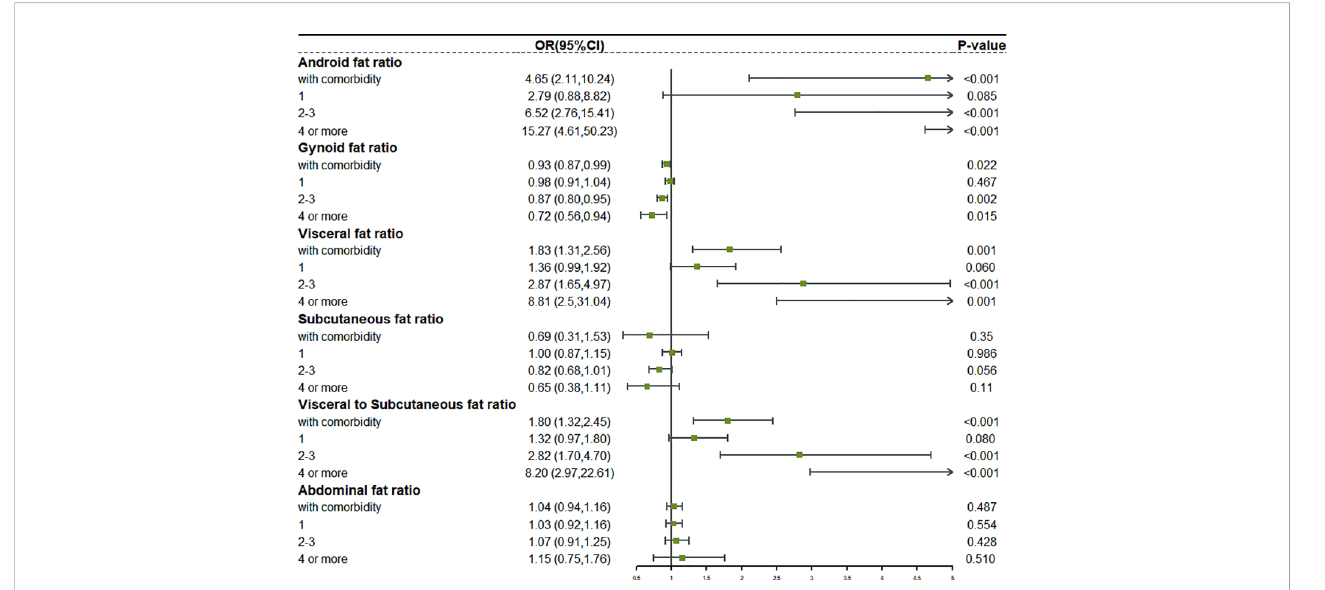
FIGURE 4 The relationship between different fat distribution and different degrees of comorbidity in obese